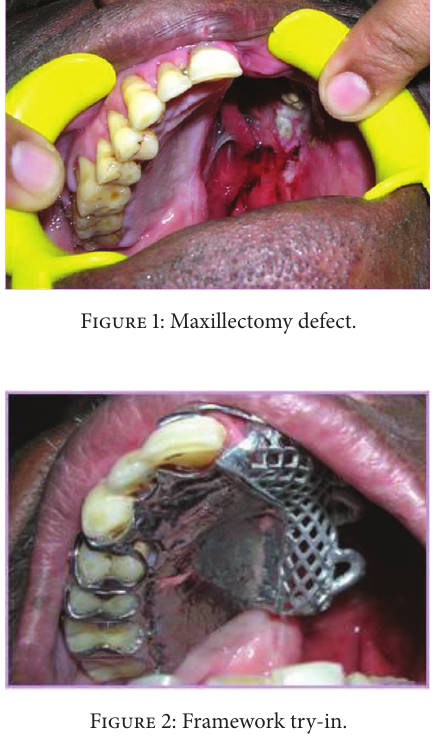
Figure 2: Framework try-in.